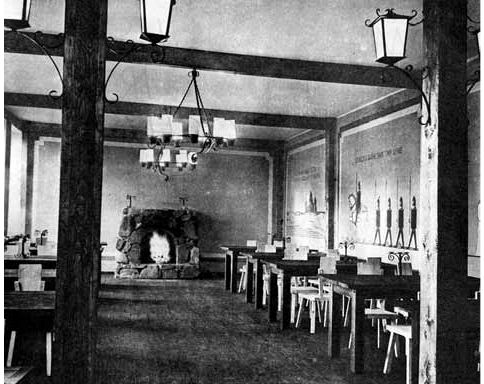
4 pav. Kapsuko (dab. Marijampolės) rajono, „naujo gyvenimo“ kolūkio (dab. Igliškėlių) kultūros namų svetainė, arch. j. Butkevičius, 1971 m. Fig. 4. Kapsukas (now Marijampolė) region, collective farm „new life“ (now Igliškėliai), reception room of House of Culture, arch. j. Butkevičius,